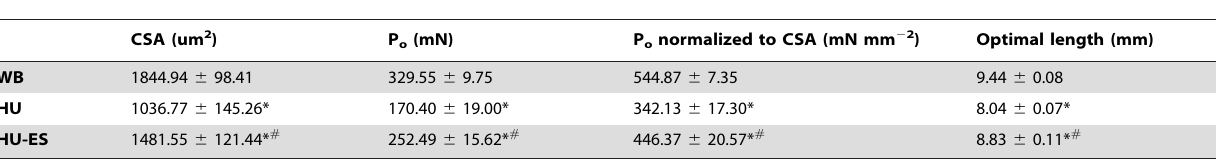
Table 2. Cross-sectional area and muscle force measurements.